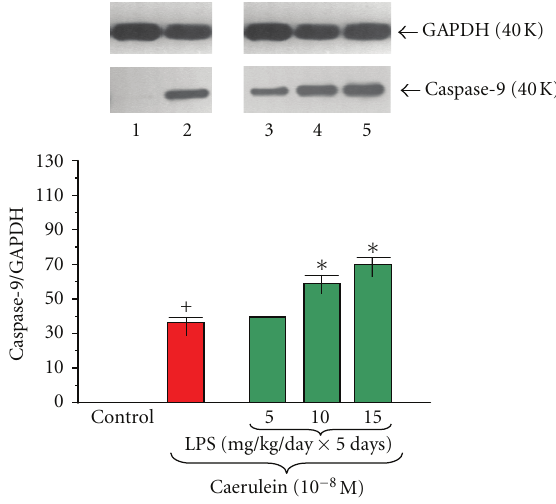
Figure 10: Western blot analysis of proapoptotic initiator caspase- 9 protein level in the adult rat pancreatic acinar cells under basal conditions (lane 1), treated in the infant animals by lipopolysac- charide ( Escherichia coli ) at the doses of 5mg/kg/day × 5 days (lane 2), 10mg/kg/day × 5 days (lane 3), and 15mg/kg/day × 5 days (lane 4) after 5 hours of incubation. The blots were stripped and probed with GAPDH to document equal protein loading. All presented results were obtained in 4 consecutive experiments and are representative of the observed phenomenon.